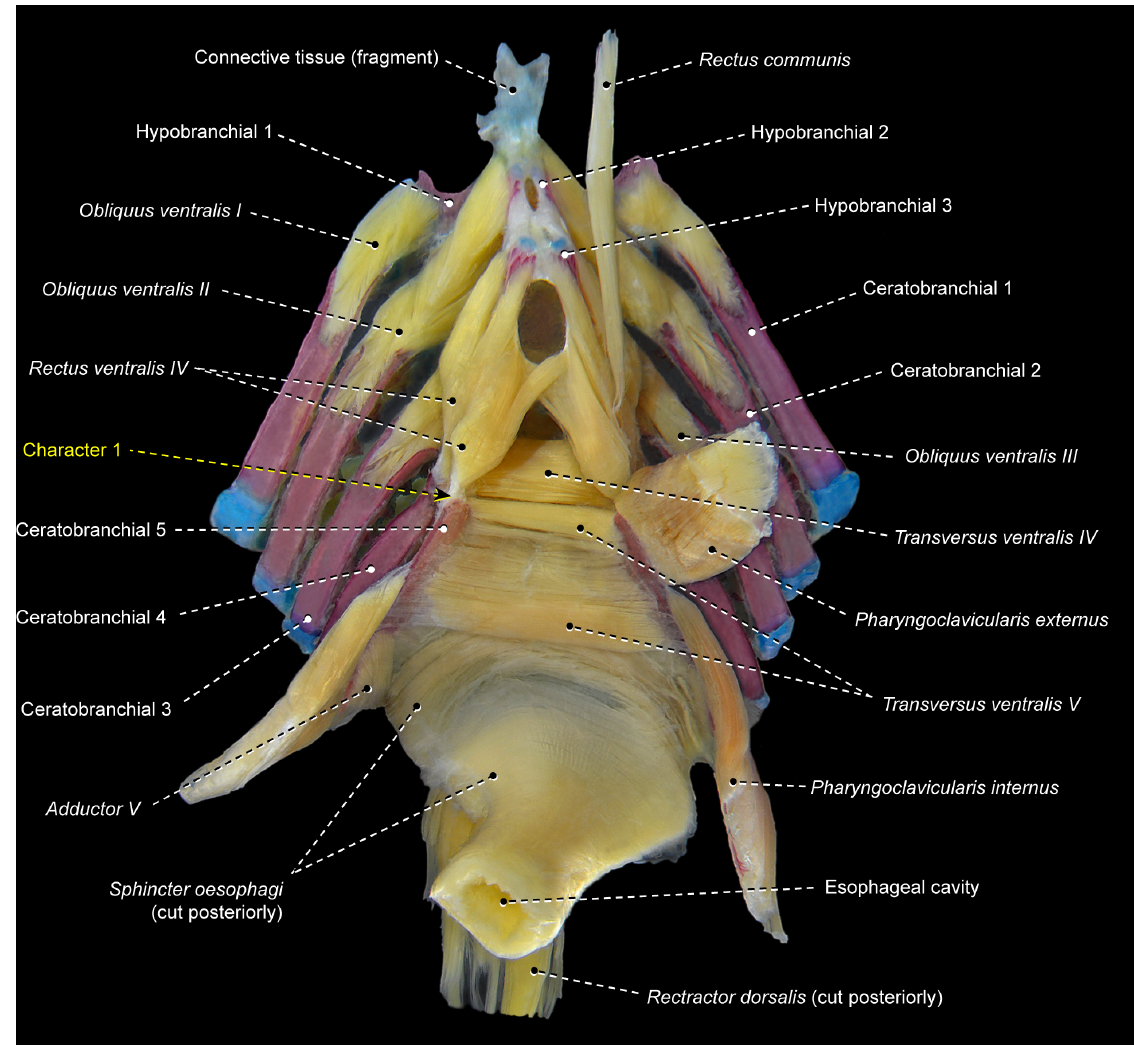
Figure 6. Branchial musculoskeletal system of Pristolepisfasciata (Perciformes: Pristolepididae). USNM 332697. Ventral view; gill rakers, right pharyngoclavicularis externus and rectus communis removed.